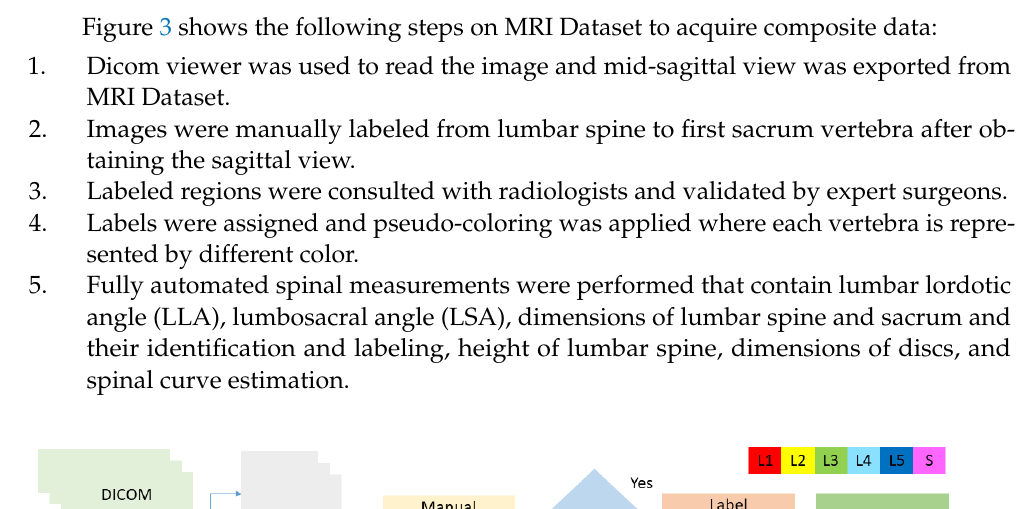
Figure 2. ( a , b ) represent the mid-sagittal view of the lumbar spine with its respective pseudo- colored labels.